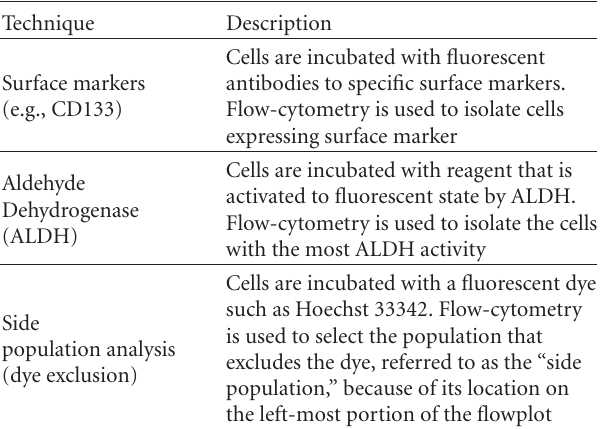
Table 1: Techniques used to isolate sarcoma-initiating